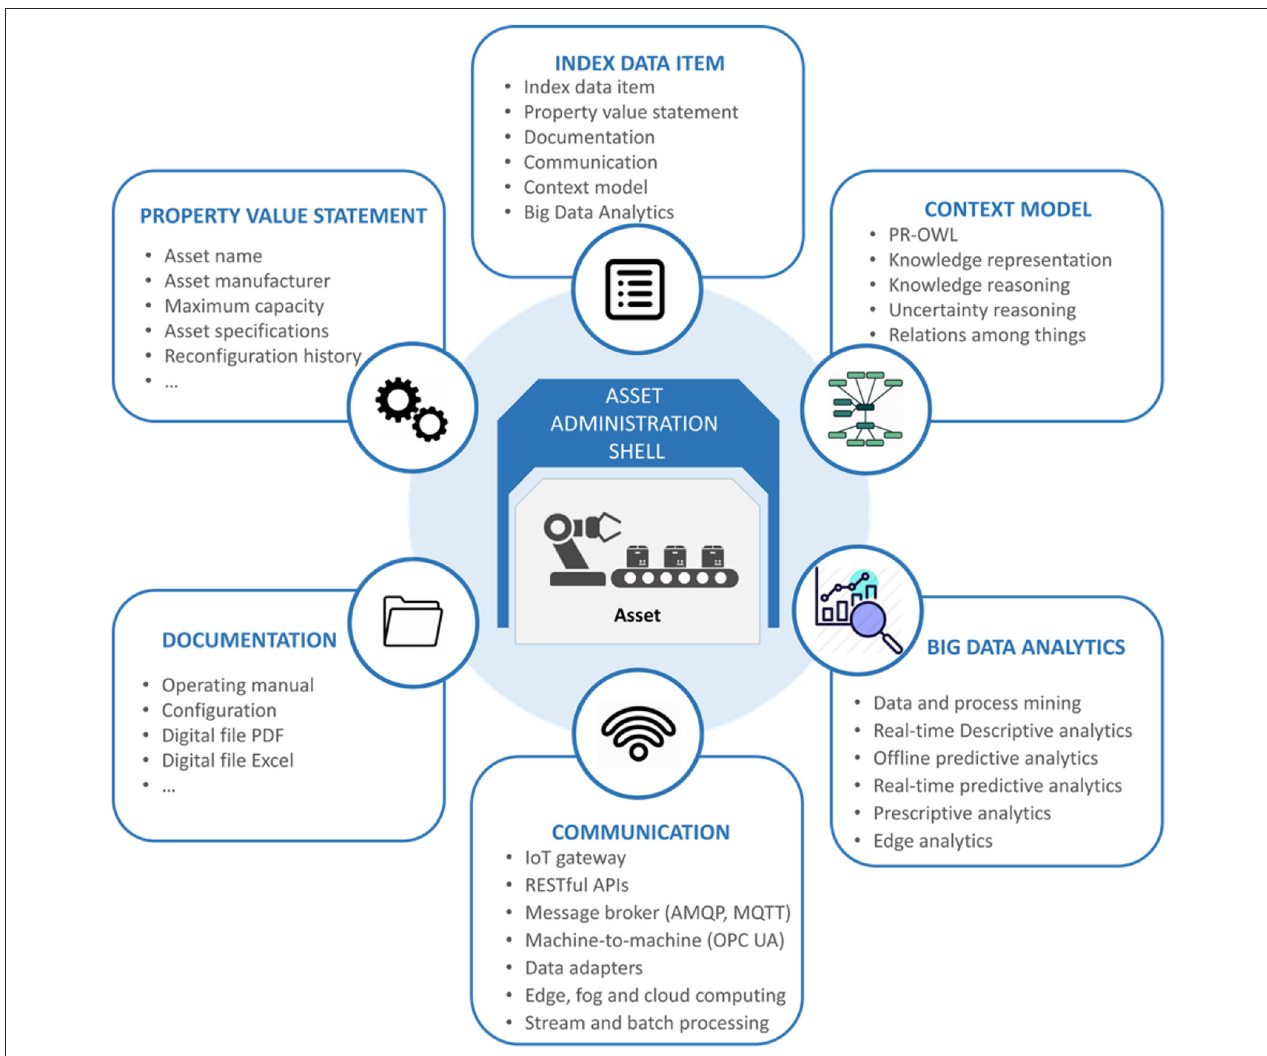
FIGURE 3 | The I4.0 AAS of the big data-driven manufacturing operations’ Digital